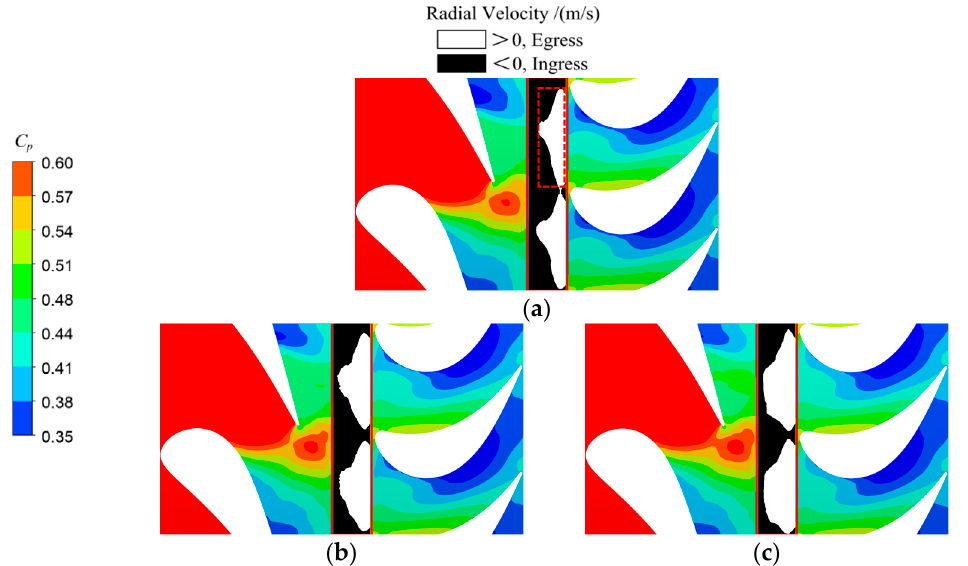
Figure 14. Radial velocity contour distribution at the clearance outlet and static pressure coefficient distribution at the endwall. ( a ) IF = 0.6%; ( b ) IF = 1.2%; ( c ) IF = 1.8%.